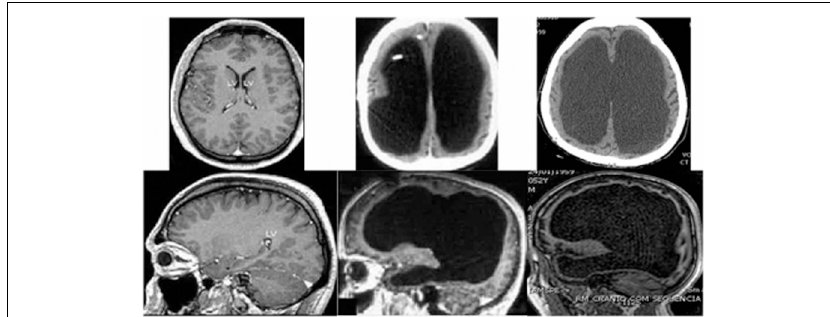
FIGURE 1 | Brain scans of patients of de Oliviera et al. (2012). Normal adult appearance (left), with “LV” referring to the small black fluid-filled ventricles. Enlarged ventricles (middle and right). The middle patient is clinically normal, whereas the right patient has had “deep cognitive and motor impairment since childhood.” Reproduced with author’s permission from Frontiers in Human Neuroscience under Creative Commons